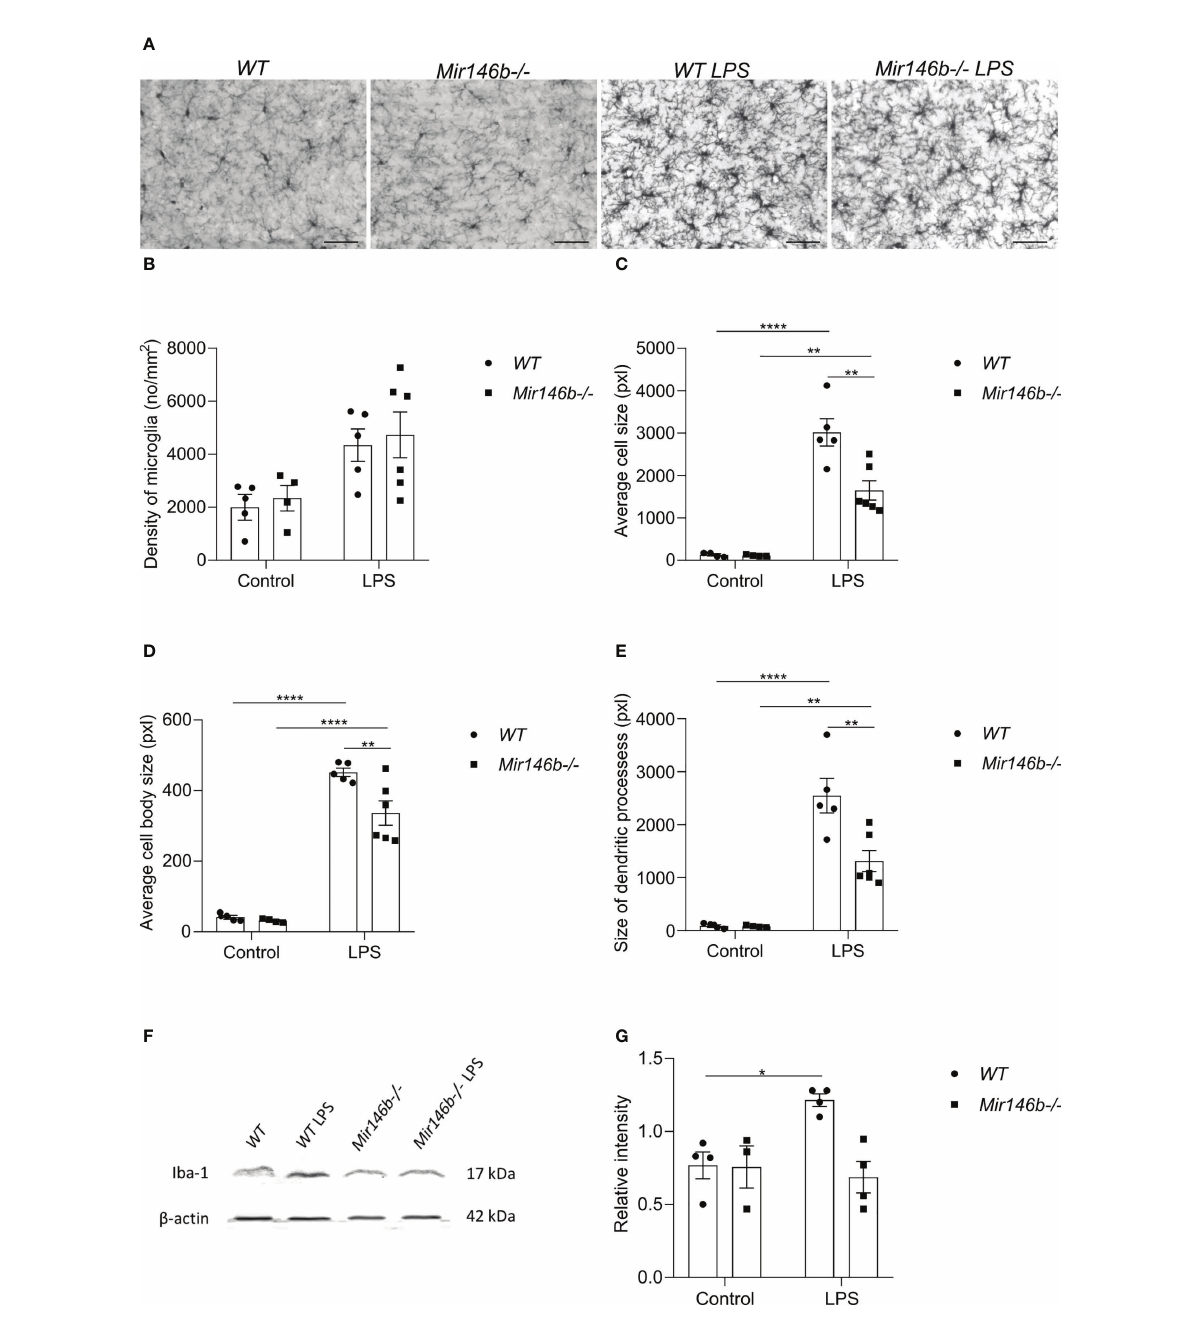
FIGURE 4 Microglial morphology and Iba1 protein levels upon LPS challenge in the hippocampus of miR-146b de fi cient and WT mice. Mice were injected with LPS in saline or equal volume of saline (control) followed by harvesting the tissues and immunohistochemistry. (A) Representative immunohistochemistry microphotographs of the hippocampal Iba1+ cells at 400× magni fi cation. (B) Density of microglial cells, (C) Average cell size, (D) Average cell body size and (E) Size of dendritic processes of microglial cells in hippocampus of WT and Mir146b-/- mice upon LPS treatment. Number of animals = 5-6. Scale bar = 50 m m. Data are represented as mean ± SEM; ** p < 0.01, **** p < 0.0001 (Two-way ANOVA with Tukey ’ s multiple comparison test). For western blot, hippocampal lysates from LPS or saline injected WT and Mir146b-/- mice were probed for Iba1 protein. (F) Representative immunoblot for Iba1 protein, (G) Densitometry quanti fi cation of Iba1. Number of animals = 4. Data are represented as mean ± SEM; * p<0.05 (Welch ’ s ANOVA with Dunnett ’ s multiple comparisons